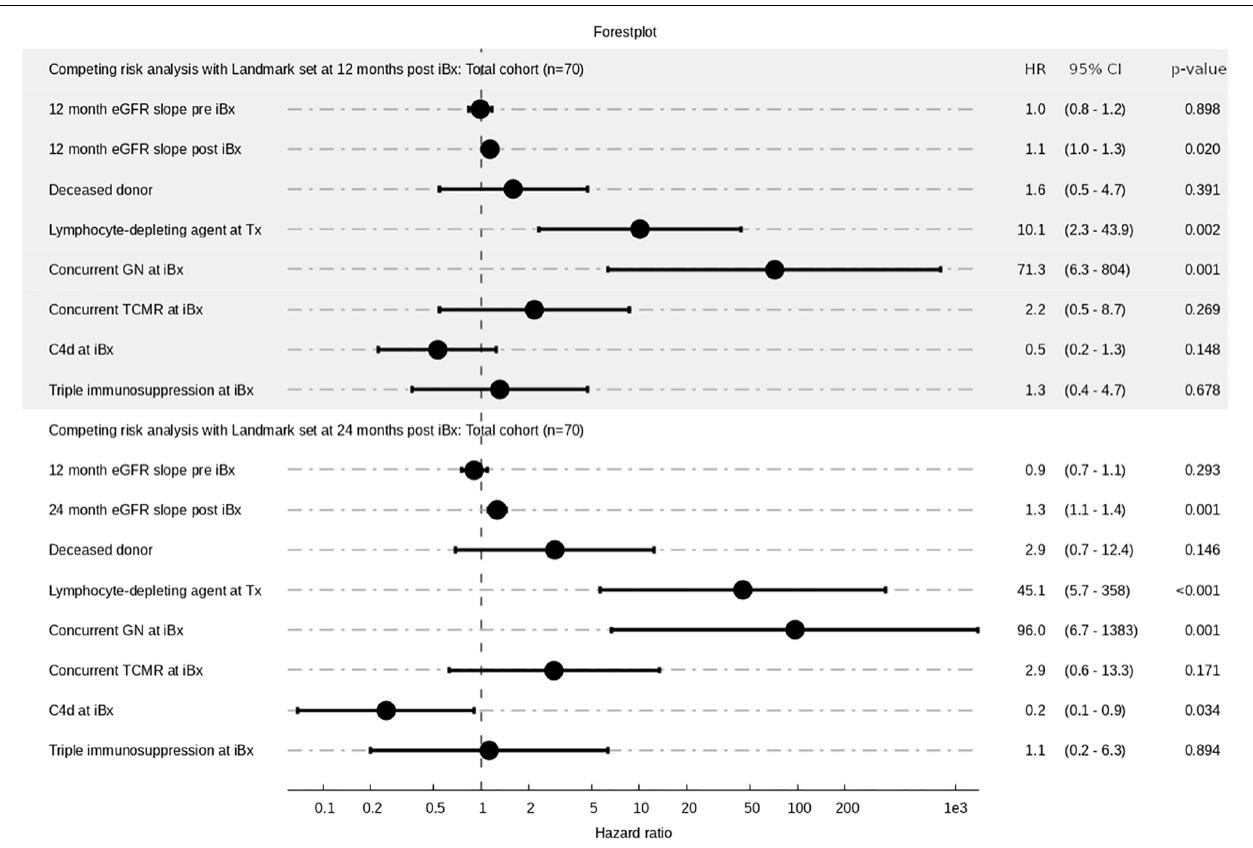
FIGURE 4 | Forest plots for the total cohort ( N = 70) with landmarks set at 12 or 24 months after iBx to avoid immortal time bias. Hazard ratios (HR’s) and their corresponding 95% confidence intervals (95% CI) are shown on the right. HR of 1 shows indifference of the variable regarding risk for allograft loss. GN, glomerulonephritis; TCMR, T cell-mediated